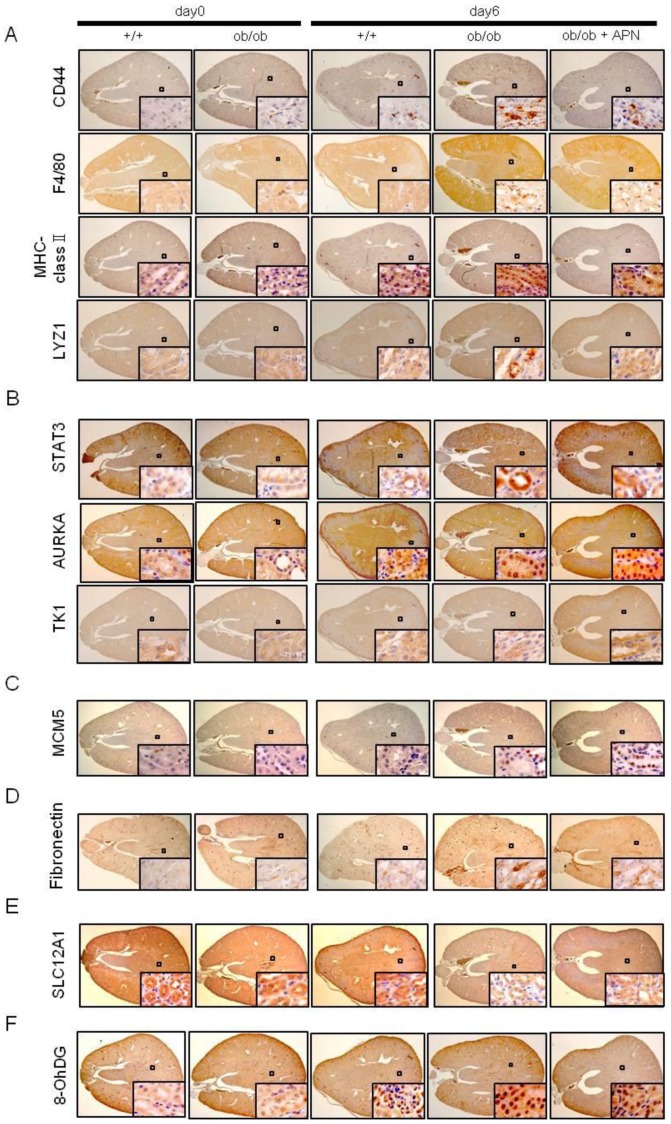
Confirmation of selected genes detected by microarray analysis.A–F. Among the selected genes with significant expression changes in the microarray analysis, the expression of several characteristic genes belonging to 6 categories based on GO analysis was evaluated by immunohistochemical staining. Magnification is ×20 (in box: ×400). 6 categories are as follows. A. Inflammation and immune-related gene group: LYZ1, Lysozyme 1.CD44, CD44 antigen; MHC-class 2, major histocompatibility complex-class2. B. Apoptosis-related gene group: STAT3, signal transducer and activator of transcription 3; AURKA, aurora kinase A, Thymidine kinase 1, C. Cell repair and proliferation-related gene group: MCM5, minichromosome maintenance deficient 5. D. Adhesion and fibrosis-related gene group: Fn, Fibronectin. E. Oxidative stress-related gene group: 8OHdG, 8-Hydroxydeoxyguanosine. F: transporter-related gene group; SLC12A1, solute carrier family 12, member 1.